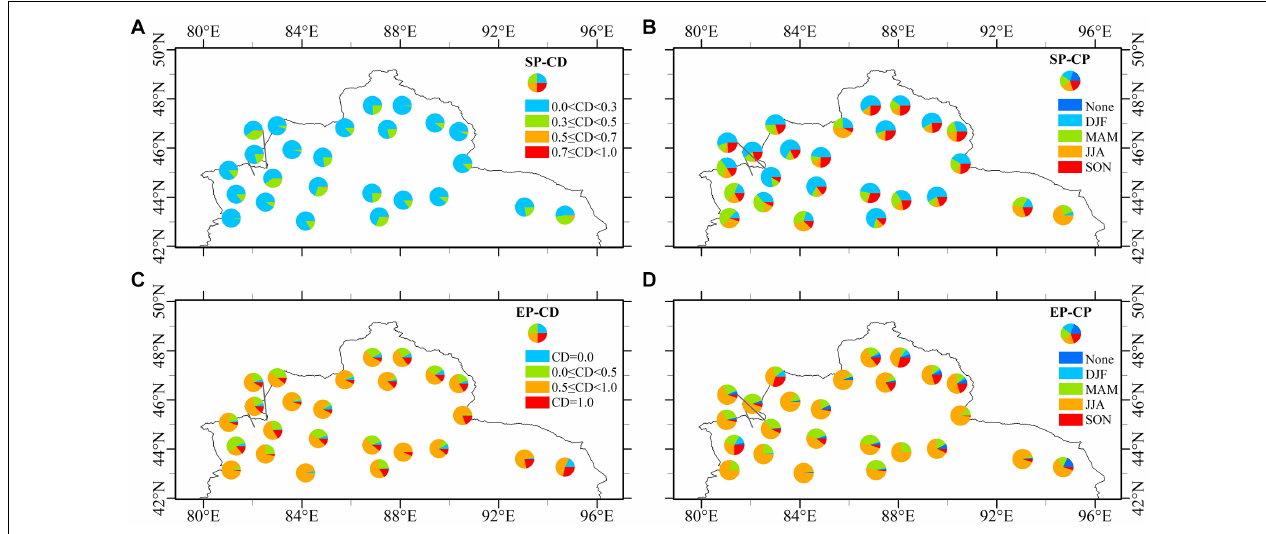
FIGURE 6 | Annual values of (A) CD, and (B) CP for SP events at each station in Northern Xinjiang from 1963 to 2017; (C,D) are as (A,B) , but for EP events. (Values of 55 years were classified into different categories).